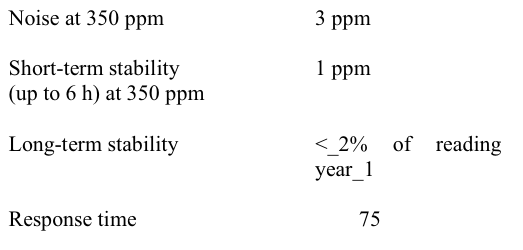
Table.1Vaisala CARBOCAP GMP343 key performance statistics (Vaisala, 2005).